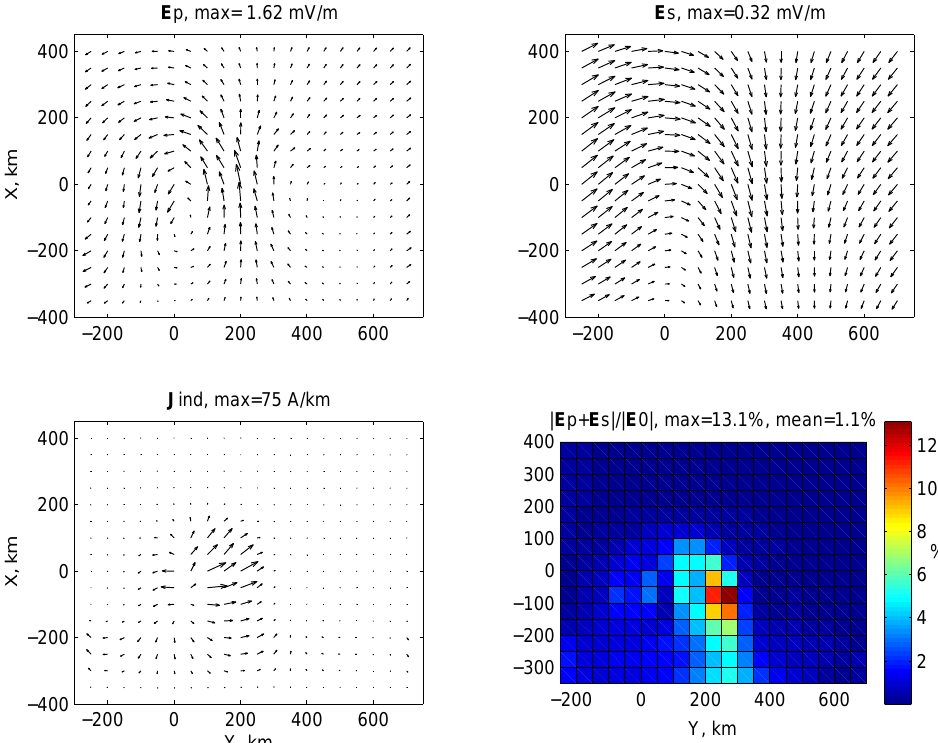
Fig. 7. Same as Fig. 5, but for the (cid:127) -band model. Note the different scales of the vector plots.